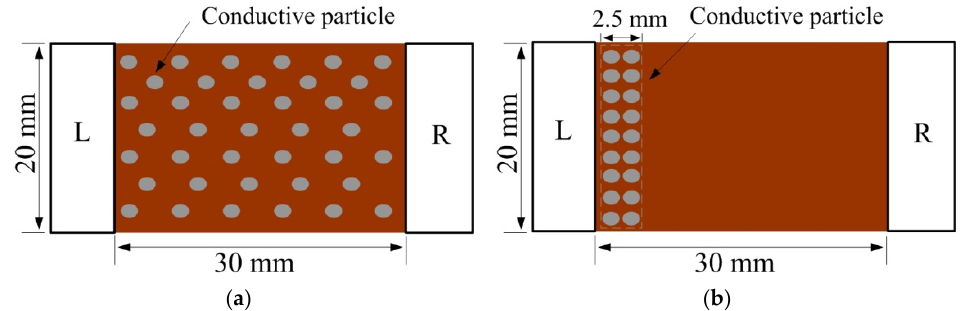
Figure 2. Schematics of particle distribution characteristics on the specimen surface. L: HV electrode; R: Grounded electrode: ( a ) Uniform distribution; ( b ) Non ‐ uniform distribution